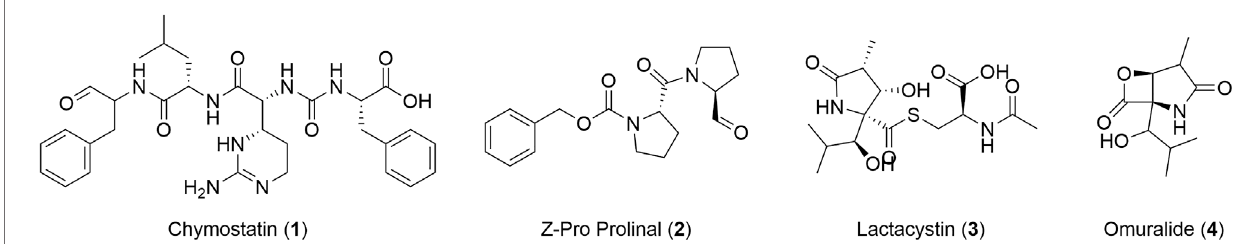
FIGURE 4 | Structure of chymostatin ( 1 ), ZPP ( 2 ), lactacystin ( 3 ), and omuralide ( 4